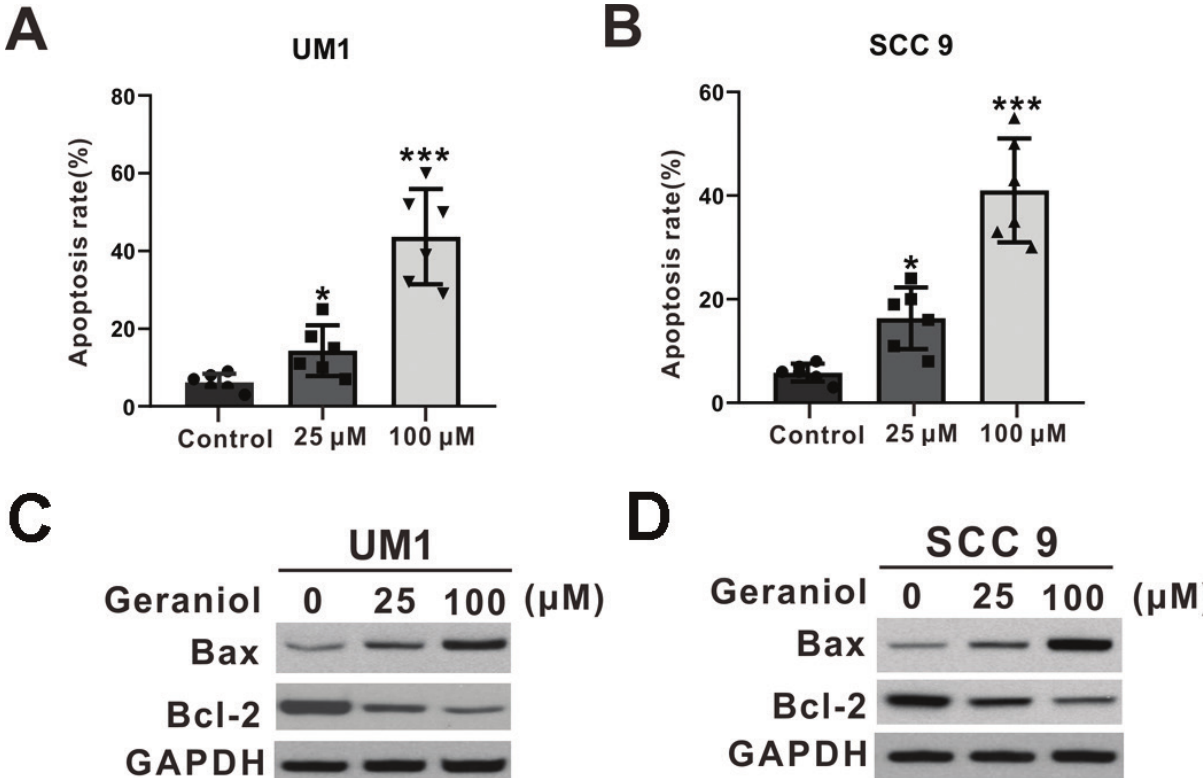
Fig. 3. Geraniol promotes apoptosis of UM1 and SCC 9 cells in a dose-dependent manner. (A–B) The apoptosis rate of indi- cated cells treated with or without geraniol at indicated concentrations was measured by TUNEL assay (terminal deoxynucleoti- dyl transferase-mediated dUTP-biotin nick end labeling assay). (C–D) The proteins associated with apoptosis were examined by Western blot. * P < 0.05 and *** P < 0.001, compared with the control